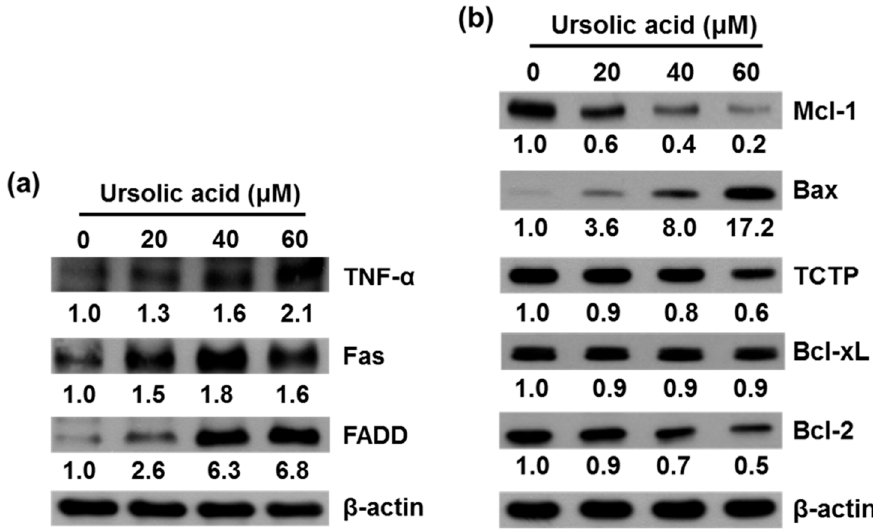
Figure 6. The effects of UA on protein expression of TNF- α , Fas, FADD, Mcl-1, Bax, TCTP, Bcl-2, and PARP in SK-Hep-1 cells. SK-Hep-1 cells were treated with UA (0, 20, 40, and 60 μ M) for 24 h and protein expression was evaluated by western blotting. The results showed that UA resulted in increased protein expression of ( a ) TNF- α , Fas and FADD; ( b ) decreased expression of Mcl-1, TCTP, and Bcl-2, and increased protein expression of Bax and Bcl-xL. β -Actin served as a loading control.